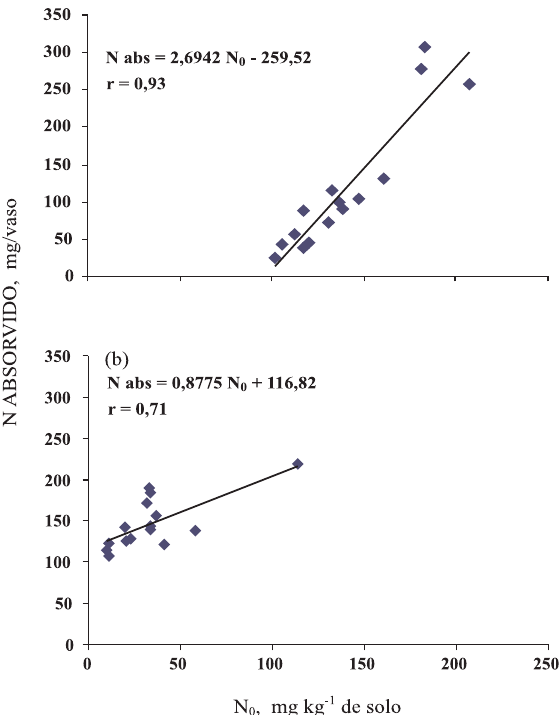
Figura 1. Correlação entre o teor de N acumulado por plantas de arroz irrigado no primeiro cultivo e o N potencialmente mineralizável (N estimado pelo modelo de Stanford & Smith (a), e o teor de N acumulado por plantas de arroz irrigado no segundo cultivo e a fração ativa do N potencialmente mineralizável, estimado pelo modelo de Jones (b), para 15 solos de várzea do